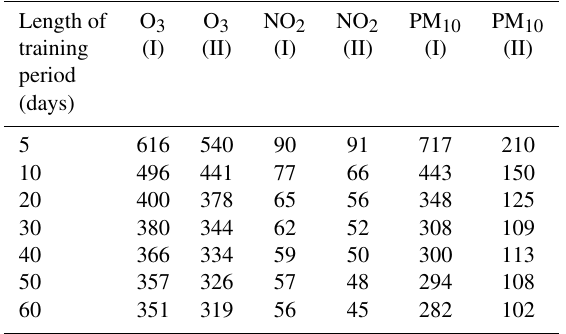
Table 5. The average MSE of mmW for various training lengths, calculated for the testing time series (i.e. not used in the training phase) that contains all